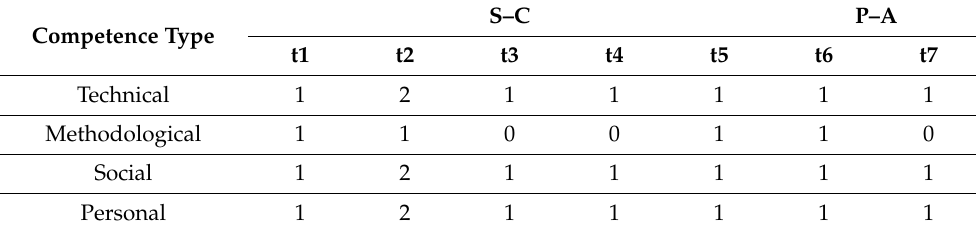
Table 11. Relevance of competence in adopting different ICT forms based on citation frequency.